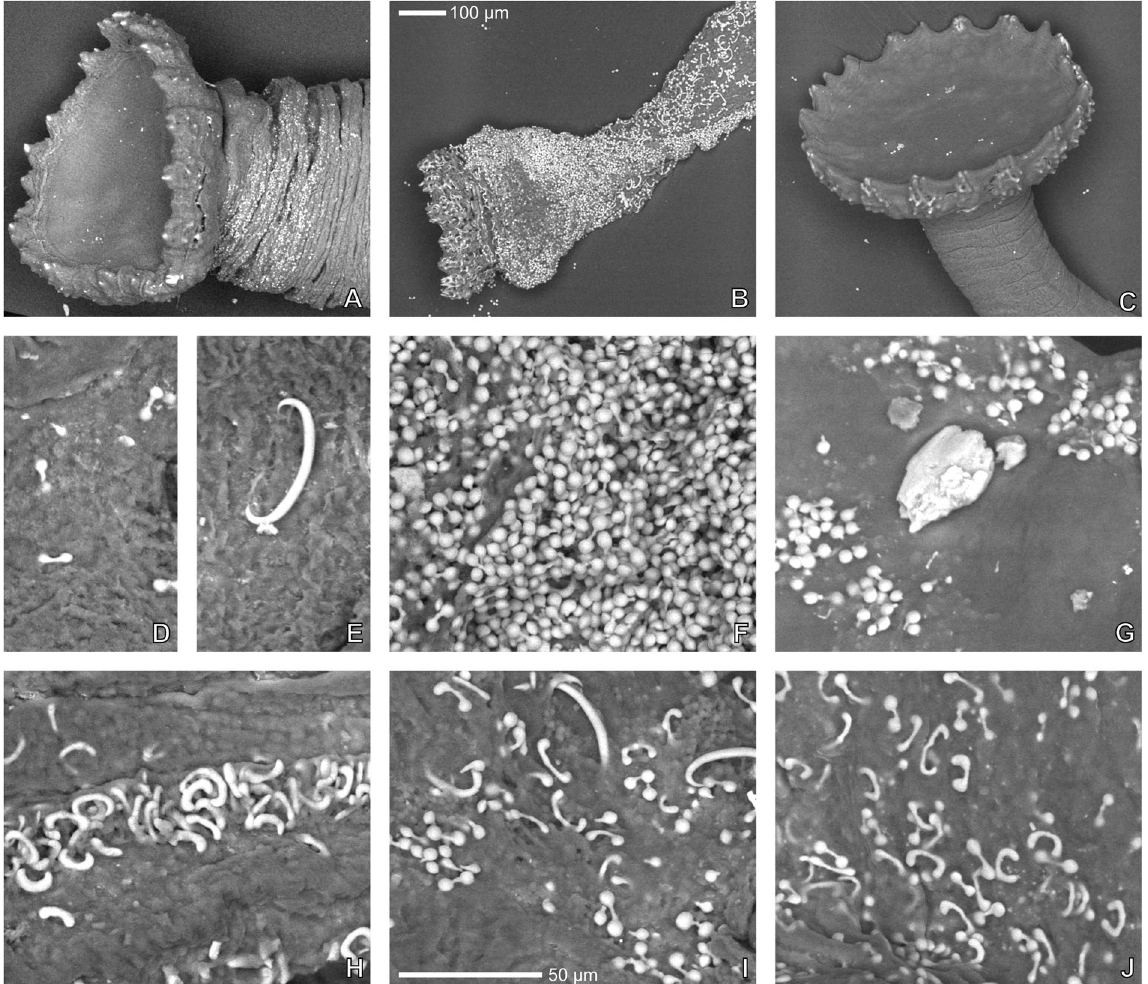
Figure 12. Tubefeet spicules of Tripneustes species. ( A , D , E , H ) Tripneustes kermadecensis n. sp. (Meyer Islands, New Zealand; paratype MA 121530.10); ( B , F , I ) Tripneustes gratilla gratilla (Philippines; CAS 187193); ( C , G , J ) Tripneustes gratilla elatensis (Aquaba, Jordan; NHMW NHMW-EV 20454). Top row: terminal disc; middle row: spicules from distal half of tube foot; Bottom row: spicules from base of tube foot. All images are backscatter electron images. 100 µ m scale bar valid for images A to C ; 50 µ m scale bar for imaged ( D ) through ( J